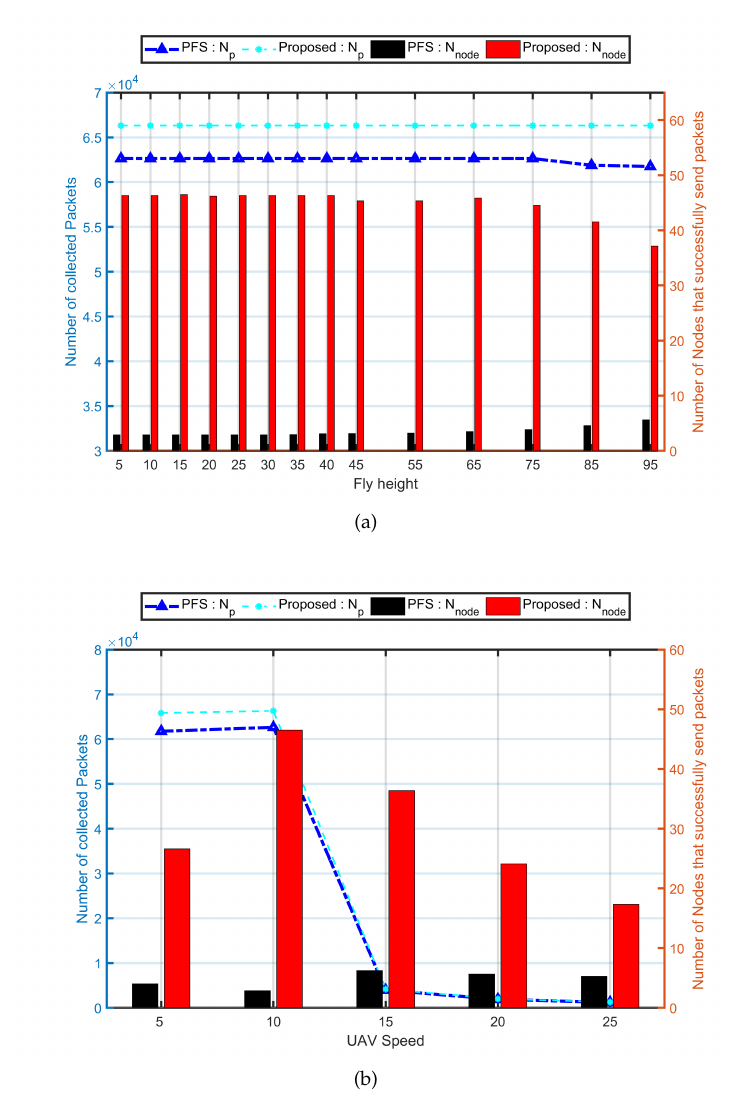
Figure 8. Network performance for varying UAV’ parameters: flight height and speed. In these simulations, the proposed algorithm is the combination of proposed Balance and PCdFS algorithms. ( a ) The number of collected packets for the network for varying fly height of the UAV. The number of nodes that successfully send packet to the UAV in the same scenario. ( b ) The number of collected packets for the network for varying UAV’ speed. The number of nodes that successfully send packet to the UAV for varying the speed of the